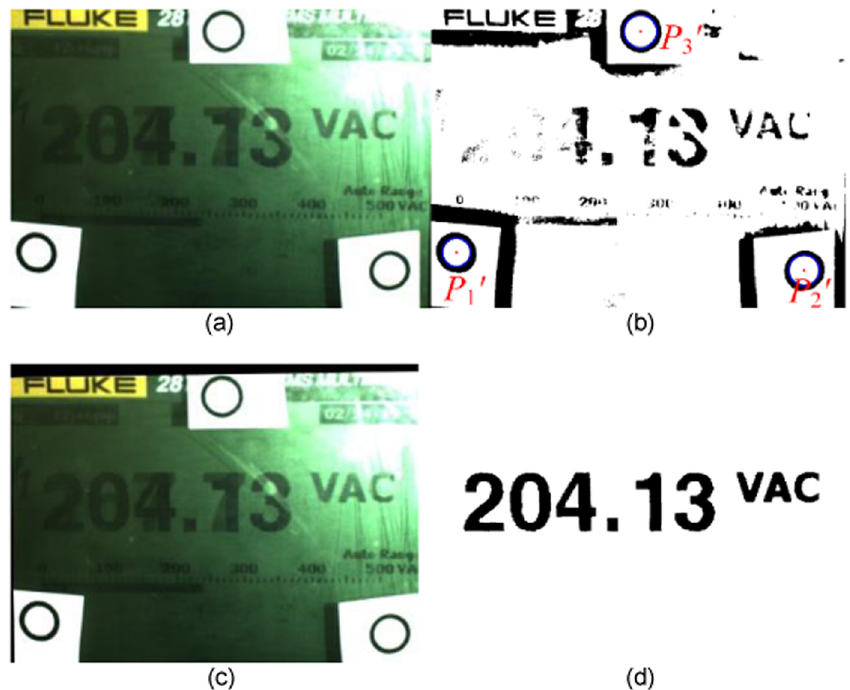
Figure 6: The label production phase. ( a ) Original image, ( b ) binary graph, ( c ) a ffi ne transformation result, and ( d ) label after character